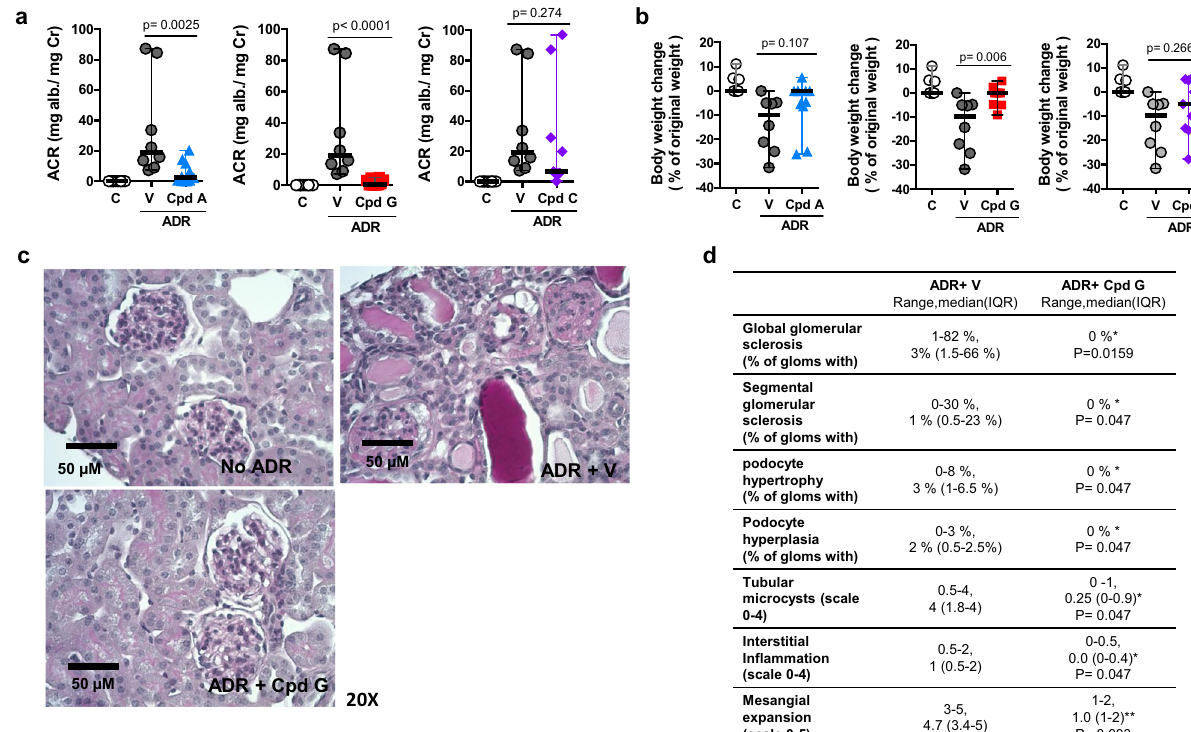
Fig. 6 Cpd G protects from kidney injury in a mouse model of adriamycin-induced nephropathy. a – d Renal phenotype of mice that received vehicle ( n = 8), Cpd A (30mg/Kg, n = 11), Cpd G (100mg/Kg, n = 10) or Cpd C (10mg/Kg, n = 8) after adriamycin (ADR) injection. A group that did not receive ADR injection (C), is included to show the healthy phenotype. a Albumin to creatinine ratio in spot urines collected 4 weeks after treatment with vehicle (V) or with Cpd A (left), Cpd G (middle) or Cpd C (right). Data expressed as median and range. Treatments with vehicle or compound were compared using a two-tailed Mann – Whitney test: Cpd A ( U = 9, P = 0.0025); Cpd G ( U = 0, P <0.0001); Cpd C ( U = 24, P = 0.286). b Weight change, as % of weight at baseline, after 4 weeks of treatment with vehicle or with Cpd A (left), Cpd G (middle) or Cpd C (right). Data expressed as median and range. Groups treated with vehicle or compound were compared using a two-tailed Mann – Whitney test: Cpd A ( U = 25, P = 0.107); Cpd G ( U = 11, P = 0.006); Cpd C ( U = 24, P = 0.274). c Representative images of PAS-stained kidney sections (magni fi cation ×20) from mice injected with saline solution (no ADR) and mice injected with ADR that received vehicle (ADR + vehicle) or Cpd G (ADR + Cpd G). d Table summarizing the quanti fi cation of histological indicators of kidney damage obtained by a blinded pathology analysis of the PAS-stained kidney sections from mice that received vehicle or Cpd G after ADR injection. Glomerular damage was quanti fi ed and is expressed as the percentage of glomeruli with the indicated phenotype. The scale used to quantify tubular microcysts and interstitial in fl ammation represent the following extent of damage: 0: 0%; 0.5: 1 – 10%; 1: 11 – 25%; 2: 26 – 50%; 3: 51 – 75%; 4: >75%. Data expressed as the range and median (interquartile range). Both groups were compared using a double-tailed Mann – Whitney test ( n = 5), * P <0.05, ** P <0.01, the exact P values are